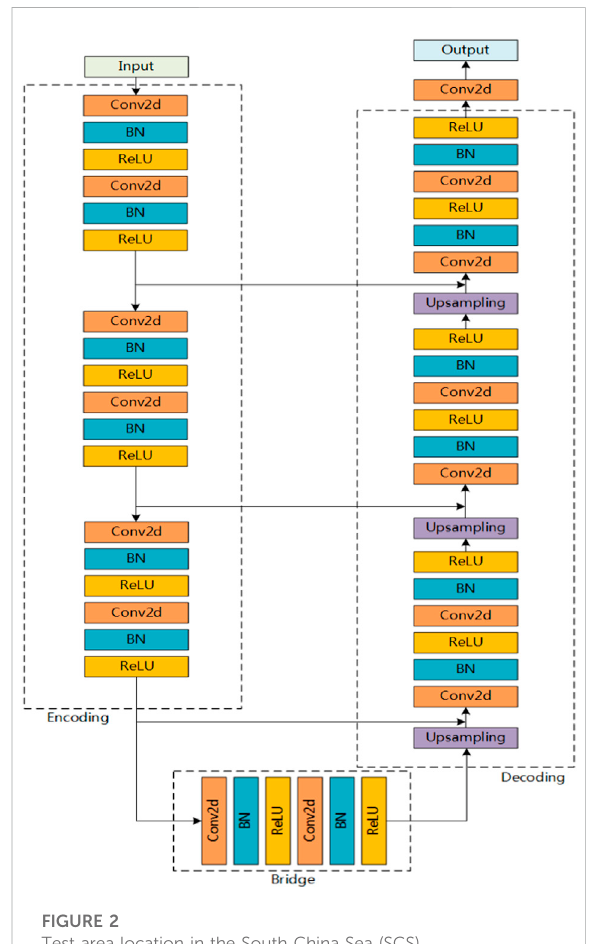
FIGURE 2 Test area location in the South China Sea (SCS).